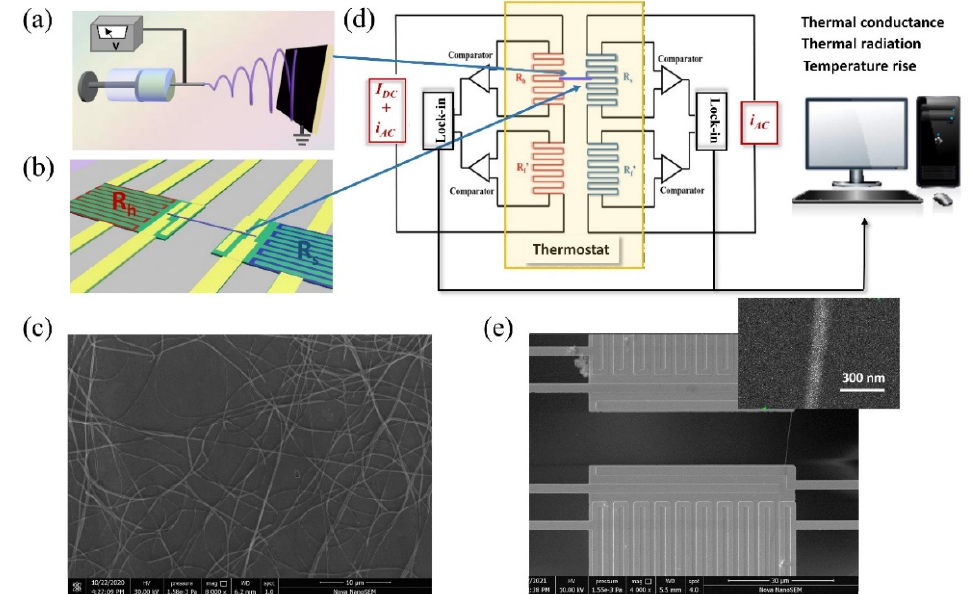
Figure 1. ( a ) the schematic diagram of the electrospinning setup; ( b ) a single nanofiber suspended on the Micro-Electro-Mechanical System (MEMS) device, the nanofiber bridge between the two islands at the center of MEMS device. The heater and thermometer are marked with R h and R s ; ( c ) a large number of electrospun PEDOT:PSS nanofibers, deposited on the tinfoil substrate. The diameters of the PEDOT:PSS nanofibers are uniform when the spinning voltage is fixed; ( d ) the schematic diagram of measuring axial thermal conductivity of PEDOT:PSS nanofiber by thermal bridge method combined with differential comparison circuit, this method is sensitive enough to characterize both thermal conductance and thermal radiation; ( e ) SEM image of a single PEDOT:PSS nanofiber suspended on the MEMS device, the scale bar is 30 µ m. The enlarged SEM image was used to measure the diameter of the sample, and the uncertainty of diameter has been considered in the subsequent measurements. The scale bar of the enlarged image is 300 nm. 1.58e-3 means 1.58 × 10 − 3